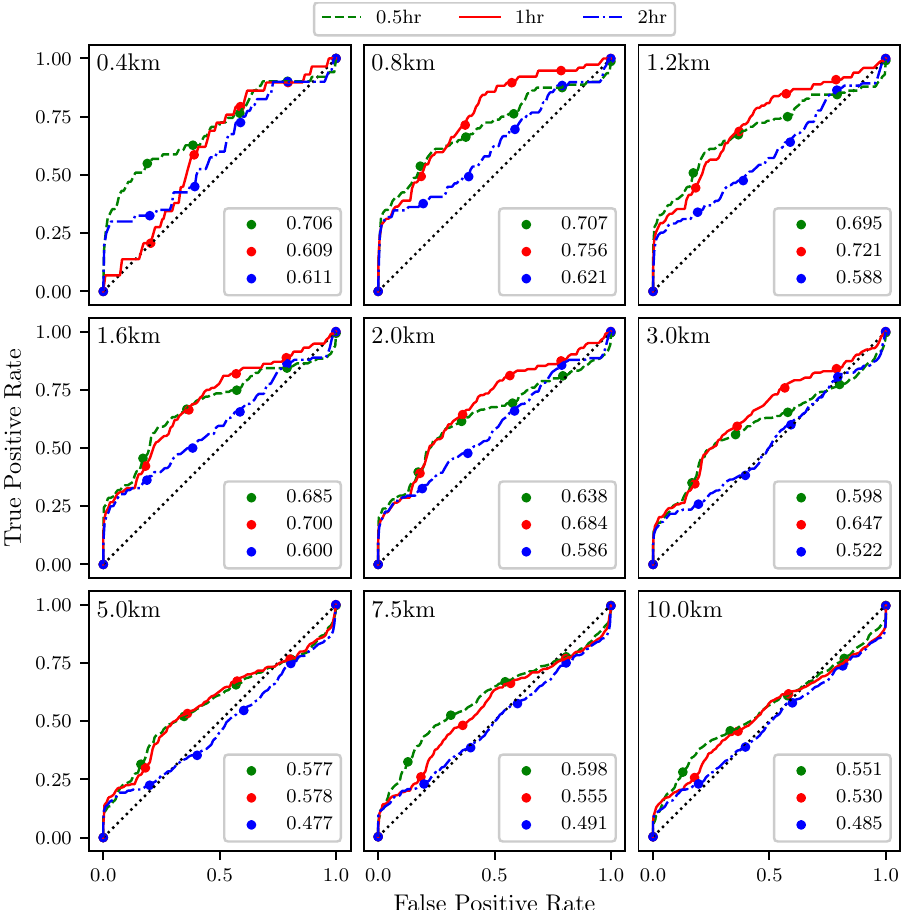
Figure 13. ROC curves for the trajectory divergence rate, ˙ ρ , as measured at the center point ability to detect 90th percentile LCSs with integration times of 0.5 ( green ), 1 ( red ), and 2 ( blue ) h. Threshold radius for each subplot is displayed in the upper left hand corner. The area under the curve (AUC) for each integration time is given in the